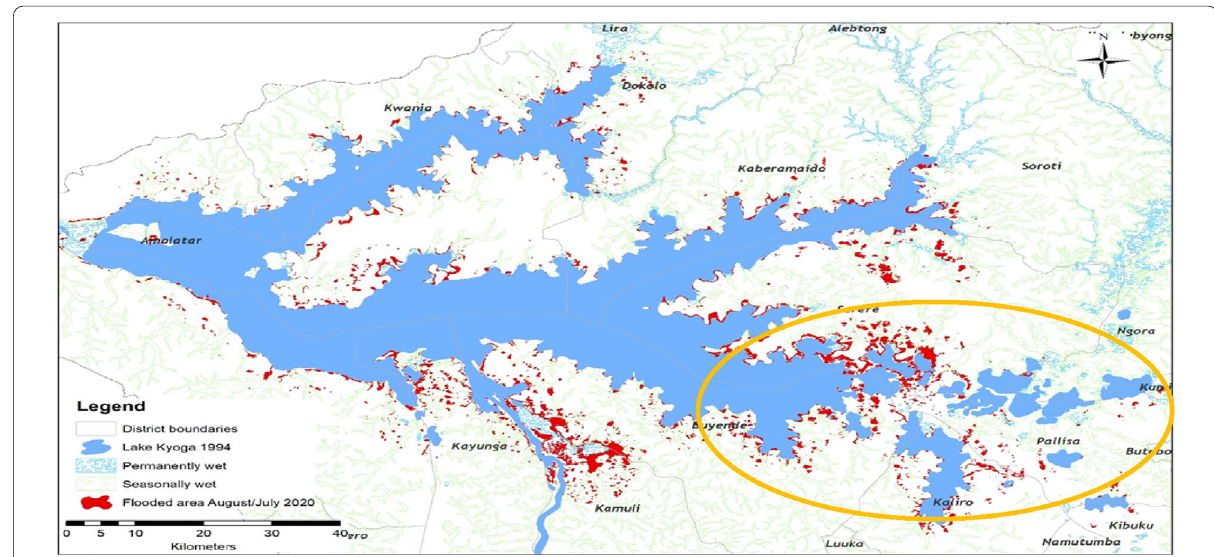
Fig. 7 A map showing the extent of 2020 floods in L. Kyoga, the yellow circle shows the study area. Data source